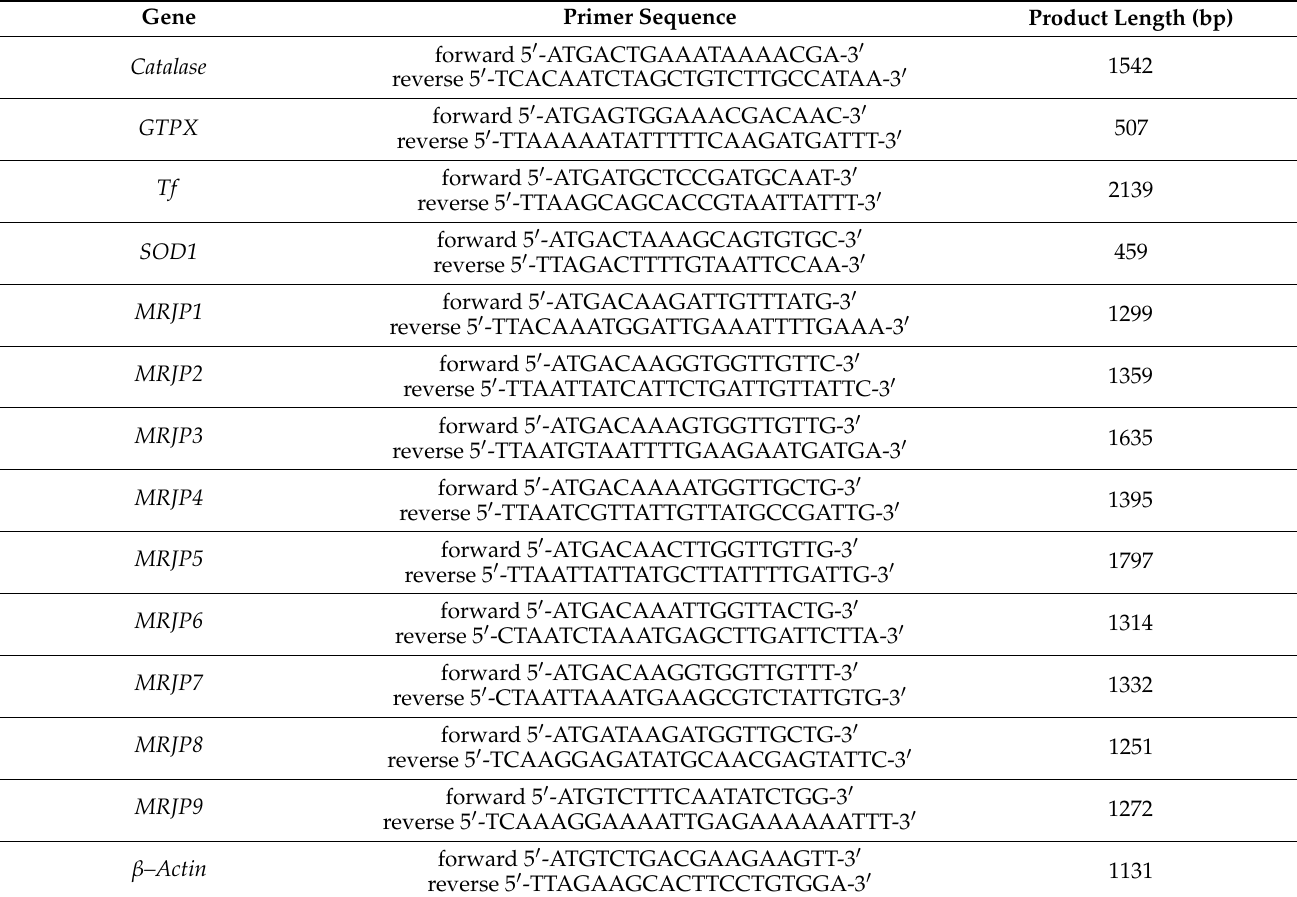
Table 1. Primers used in the RT-PCR analysis of the genes encoding antioxidant proteins and MRJPs in the spermathecae of virgin and mated queens. Gene Primer